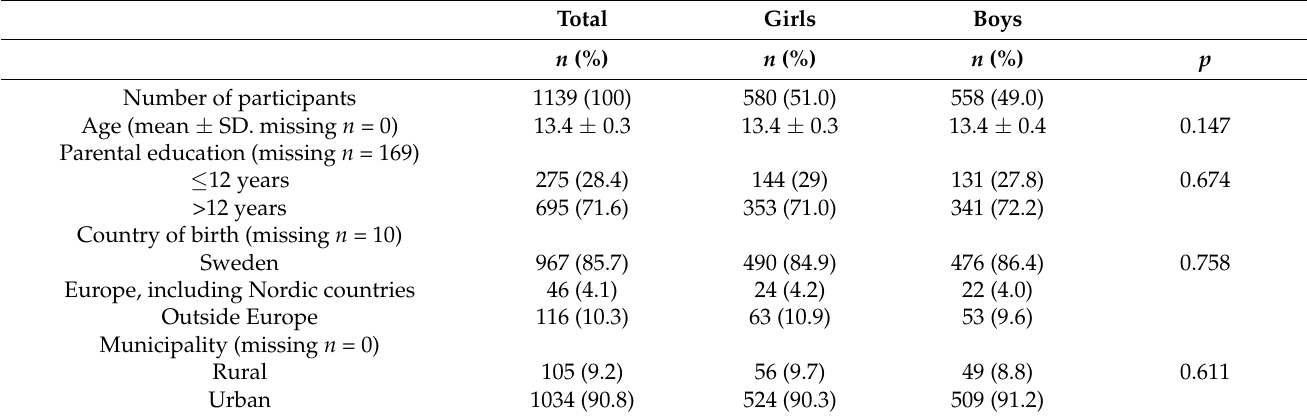
Table 1. Characteristics of the study